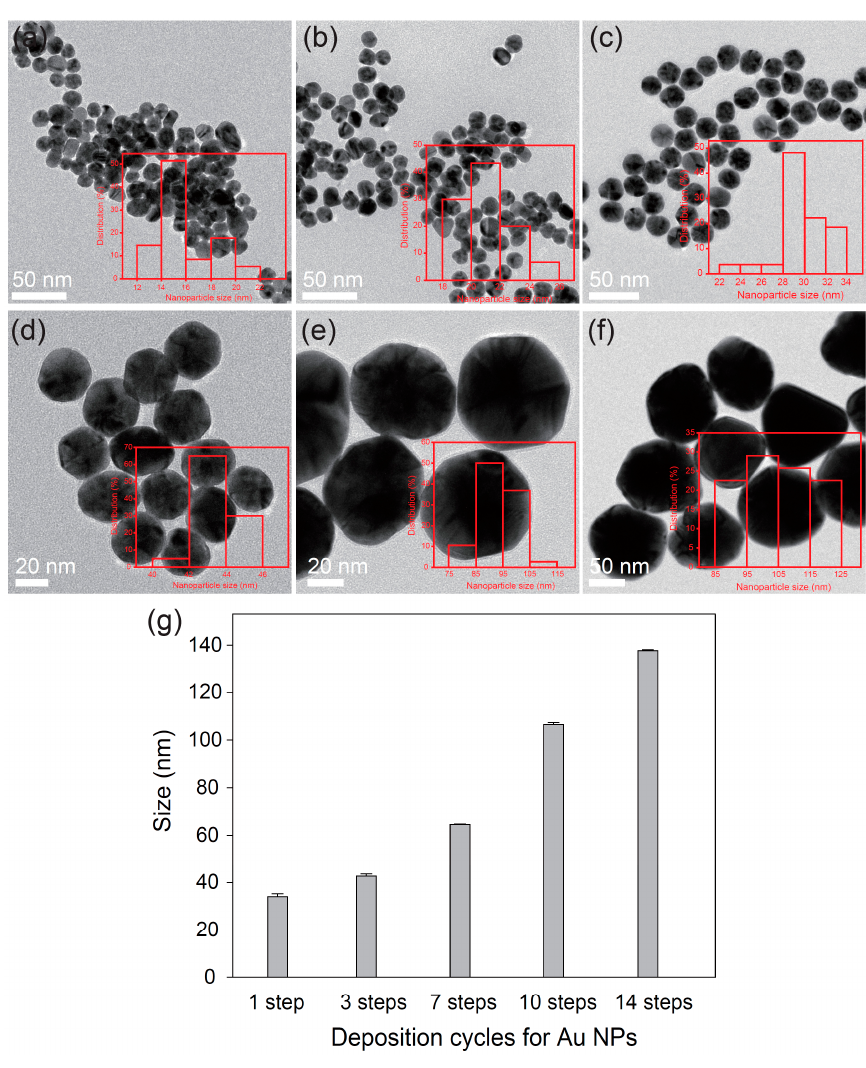
Figure 1. TEM images of ( a ) AuNP seeds and different-sized AuNPs according to growth steps; ( b ) 1 step; ( c ) 3 steps; ( d ) 7 steps; ( e ) 10 steps; and ( f ) 14 steps. Insets are size distribution diagrams for different-sized AuNPs. ( g ) AuNP sizes obtained from DLS.